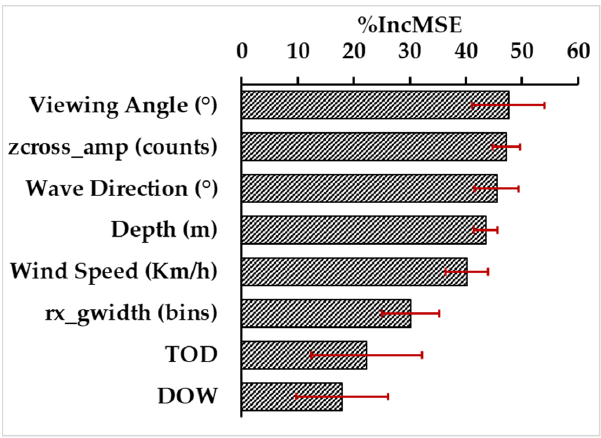
Figure 10. Variables’ order of importance in the error estimation random forest regression model with the %IncMSE (higher values mean higher importance).